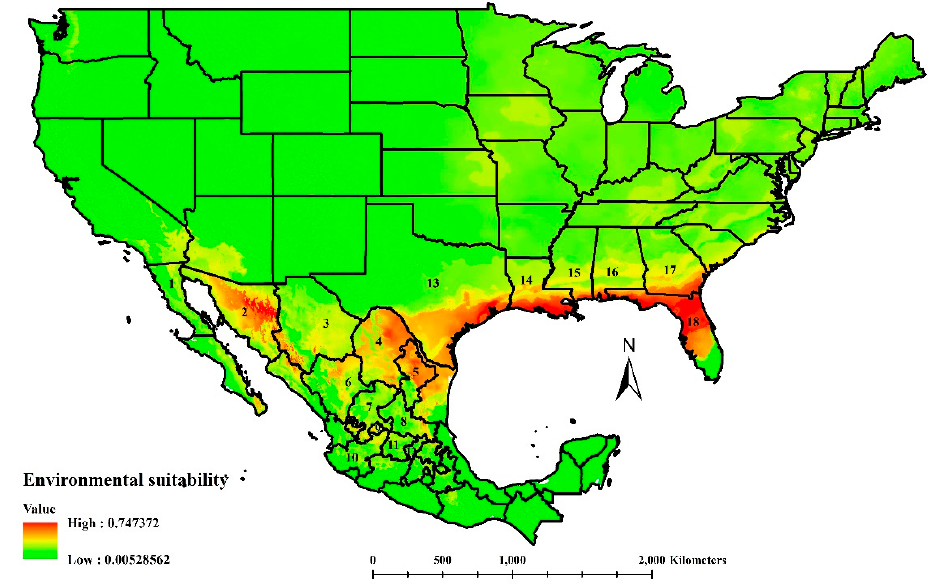
Figure 2. Environmental suitability for the cactus moth, Cactoblastis cactorum , in North America according to the division by states for Mexico and the United States. State identifications for Mexico include (1) Baja California, (2) Sonora, (3) Chihuahua, (4) Coahuila, (5) Nuevo Leon, (6) Durango, (7) Zacatecas, (8) San Luis Potosi, (9) Aguascalientes, (10) Jalisco, (11) Guanajuato, and (12) Queretaro. State identifications for the United States includes (13) Texas, (14) Louisiana, (15) Mississippi, (16) Alabama, (17) Georgia, and (18) Florida. As the environmental suitability level moved towards the red end of the scale, a more significant environmental suitability for C. cactorum was calculated.